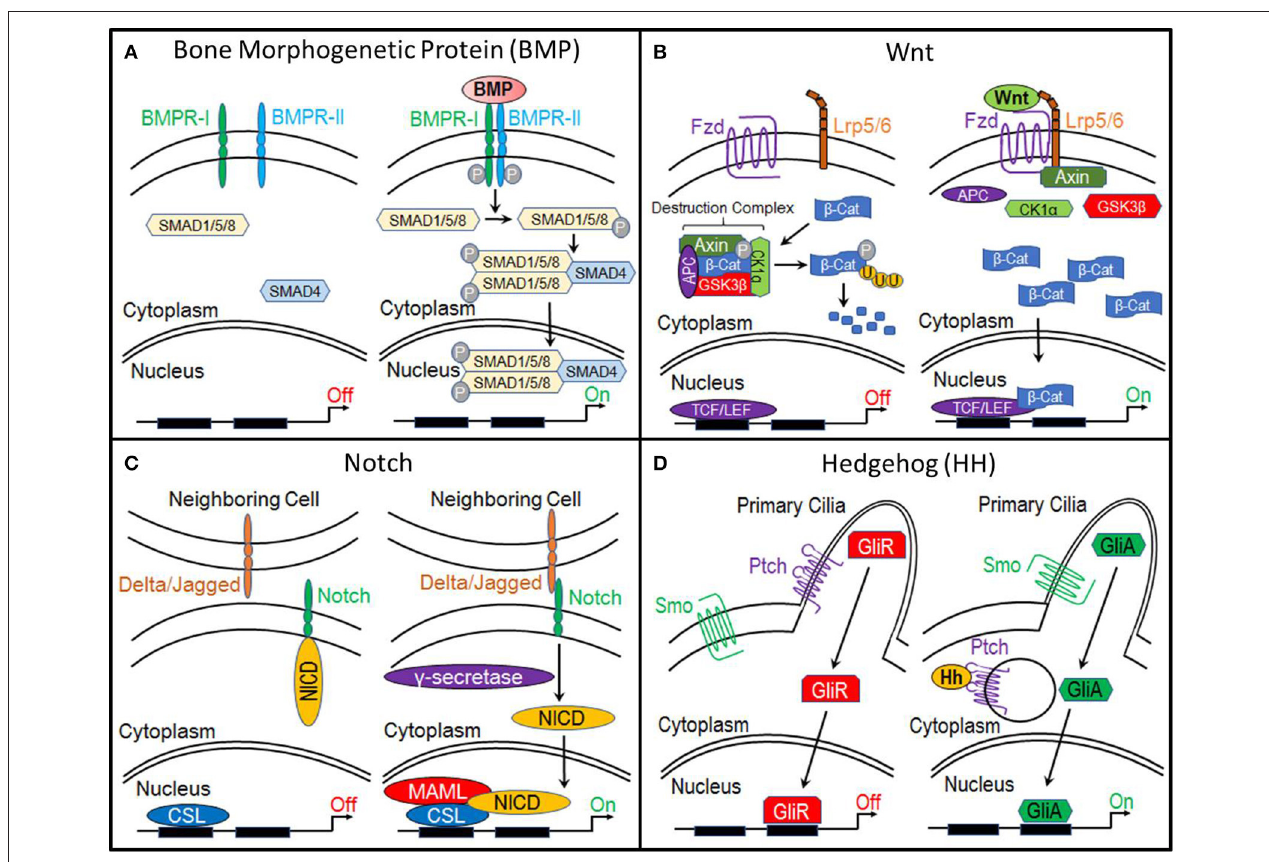
FIGURE 1 | Molecular pathways. (A) Bone Morphogenetic Protein (BMP), (B) Canonical Wnt, (C) Notch, and (D) Hedgehog.